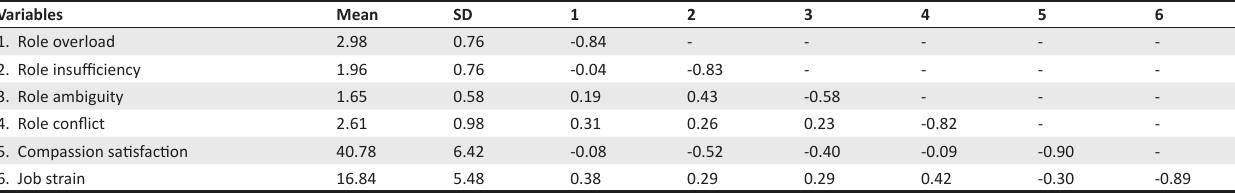
TABLE 1: Means, standard deviations and correlations for the study variables.